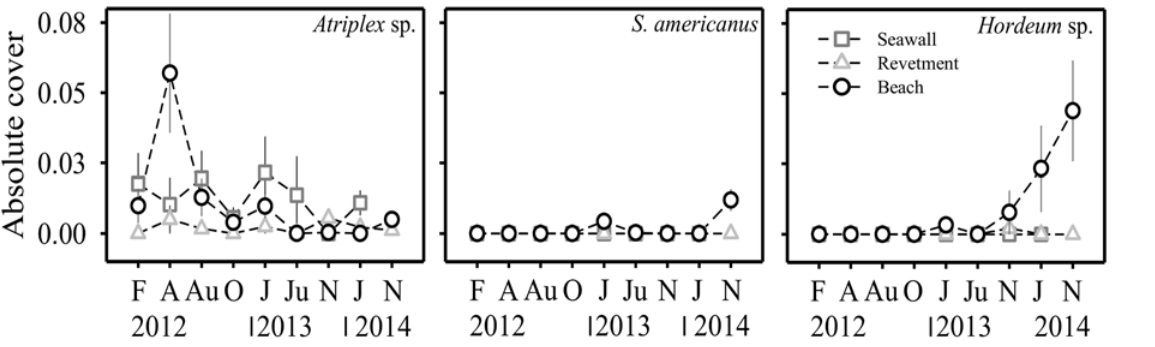
Fig 5. Absolute cover of Atriplex spp., Schoenoplectus americanus , and Hordeum spp. The plots show the standardized mean values (1 ± SE, n = 4 transects) of the three study sites over time (sampling times and study sites as in Fig 3).